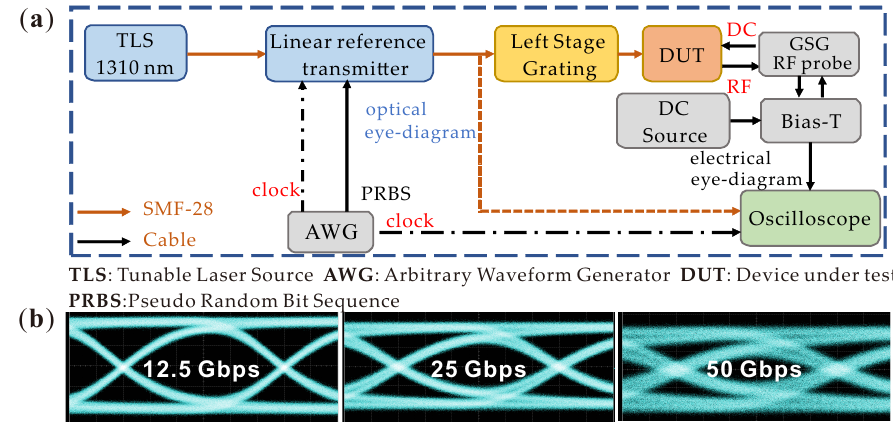
Figure 9. ( a ) Experimental setup for the eye diagram measurement. ( b ) Measured 12.5 Gb/s, 25 Gb/s, and 50 Gb/s eye diagrams of the